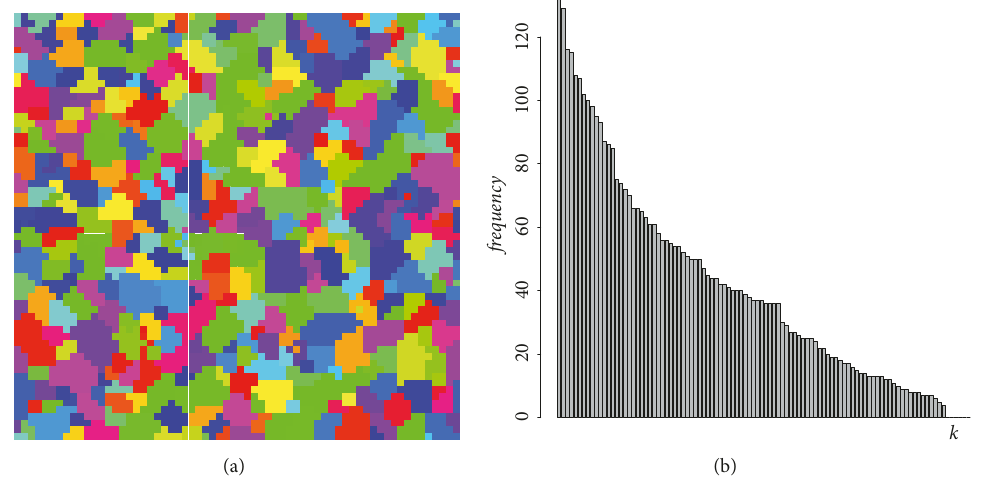
Figure 3: Example of a fixed point solution for 𝑠 = 2 , 𝑝 𝑎 = 0.75 , and 𝑝 𝑏 = 0.25 . (a) The spatial patterns of selected schools (the colormap labels the states {1,2,. .. 100} ). (b) The distribution of the number of students per school.